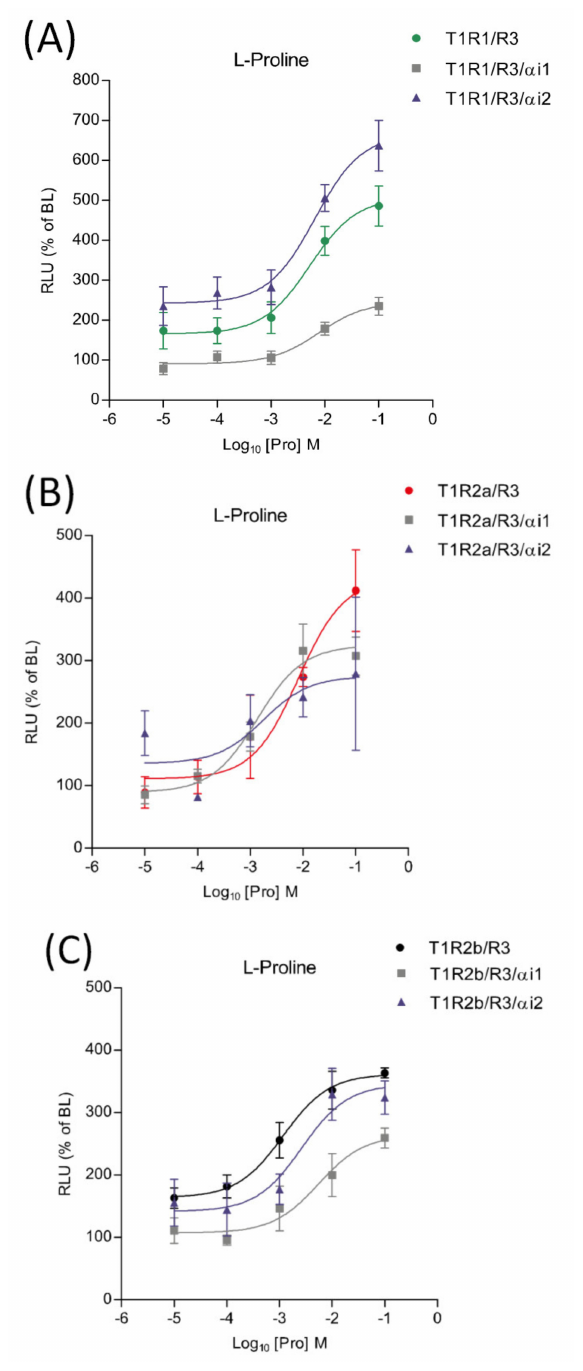
Figure 10. Comparisons of proline Log-dose response curves of activation in heterologous transfections of saG α i1 and saG α i2 in combination with saT1R1 / R3 ( A ), saT1R2a / R3 ( B ) and saT1R2b / 3 ( C ). Evaluation of proline responses was based on the RLU mean ± SEM of four independent determinations normalized to the mean response of same transfections stimulated with reduced assay medium (BME + 1% FBS), expressed as the percentage relative to basal levels